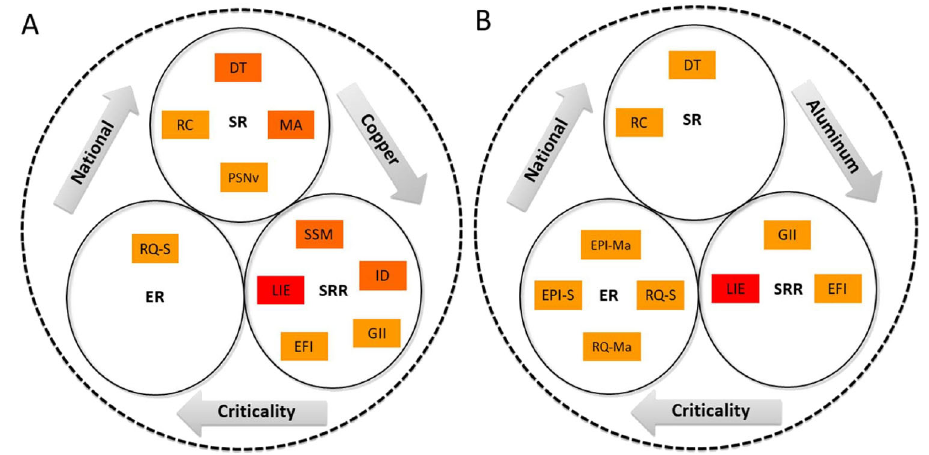
Fig. 5 National level criticality assessment using the single-metal approach. a copper. b aluminum. The single-metal approach is adopted to examine China ’ s criticality situation.